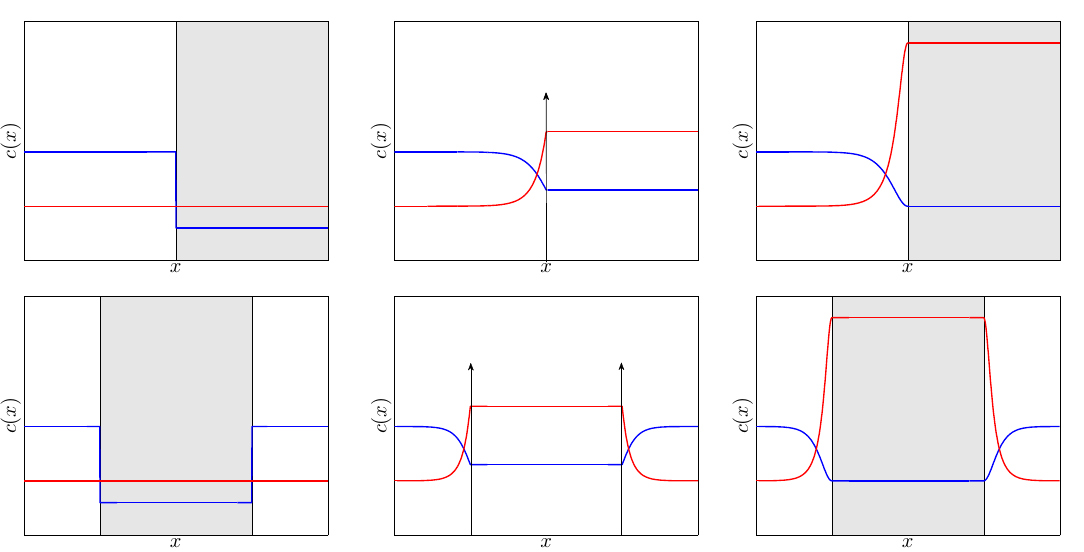
Figure 3. Schematic plot of the spatial profile of sound (blue) and flow (red) velocities for typical black hole (BH) (upper row) and the corresponding black-hole laser (BHL) (lower row) configurations. Left column: flat-profile configuration, where the shaded area represents the region with different values of the coupling constant, g ( x ) = g 2 . Central column: delta-barrier configuration, where the arrows represent the position of the delta potential. Right column: waterfall configuration, where the shaded area represents the region in which the negative step potential V ( x ) = − V 0 is